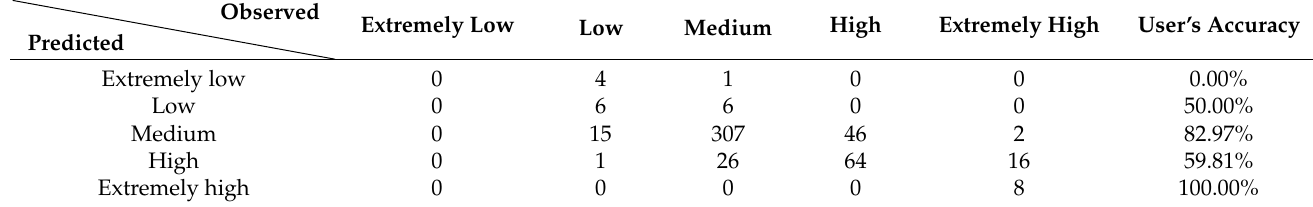
Figure 2. Scatterplot of the predicted TN values versus the observed TN values. Table 6. Allocation confusion matrix of TN.